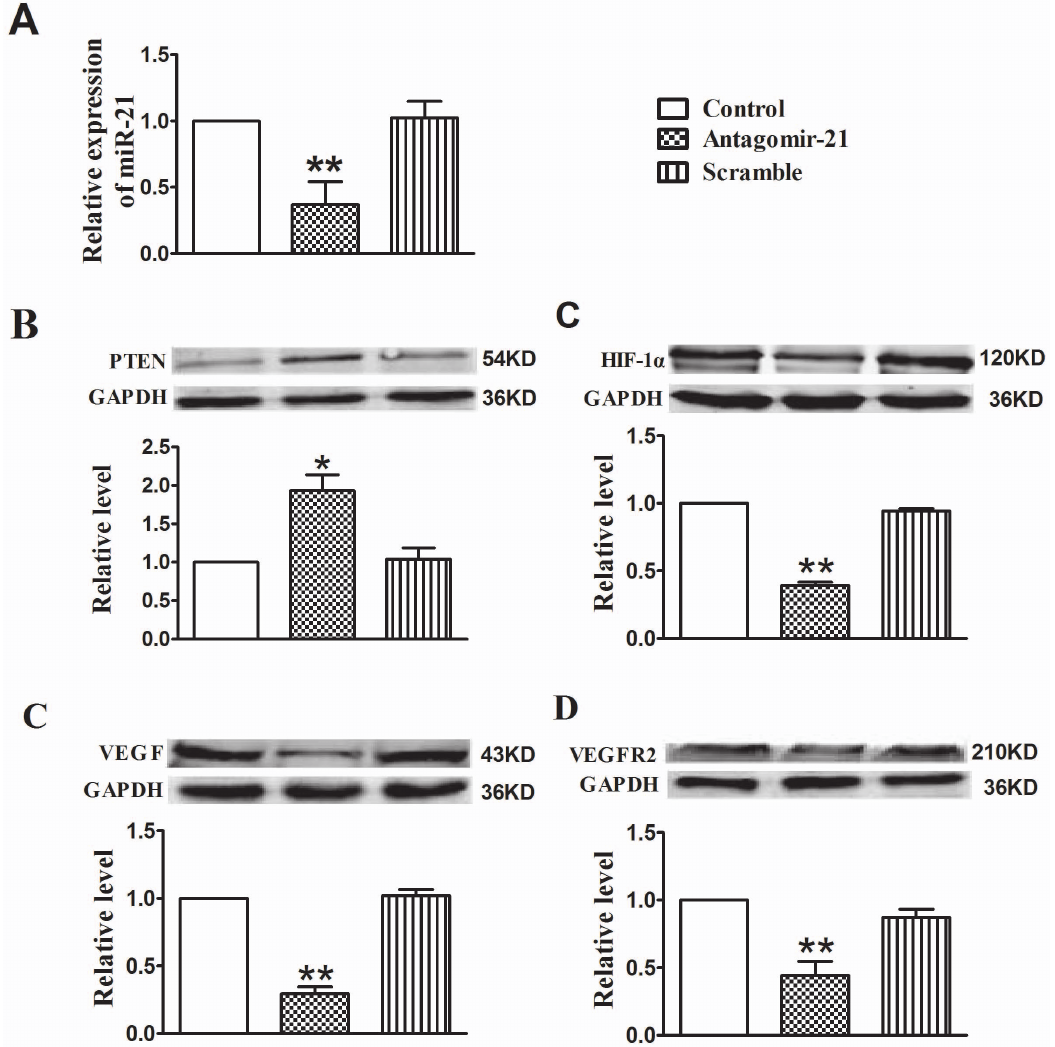
Figure 7. Down-regulation of miR-21 with antagomir-21 inhibits angiogenesis through targeting HIF-1 a /VEGF/VEGFR2 signaling pathway. (A)Expression levels of miR-21 in tumors treated with miR-21 mimic, antagomir-21 or scramble. Data are expressed as mean 6 SEM. ** P , 0.01 vs control group. (B–E) Protein levels of PTEN, HIF-1 a , VEGF and VEGFR2 were analyzed by Western blotting assay. Data are expressed as mean 6 SEM. n=3 in each group. * P , 0.05 vs control group, ** P , 0.01 vs control